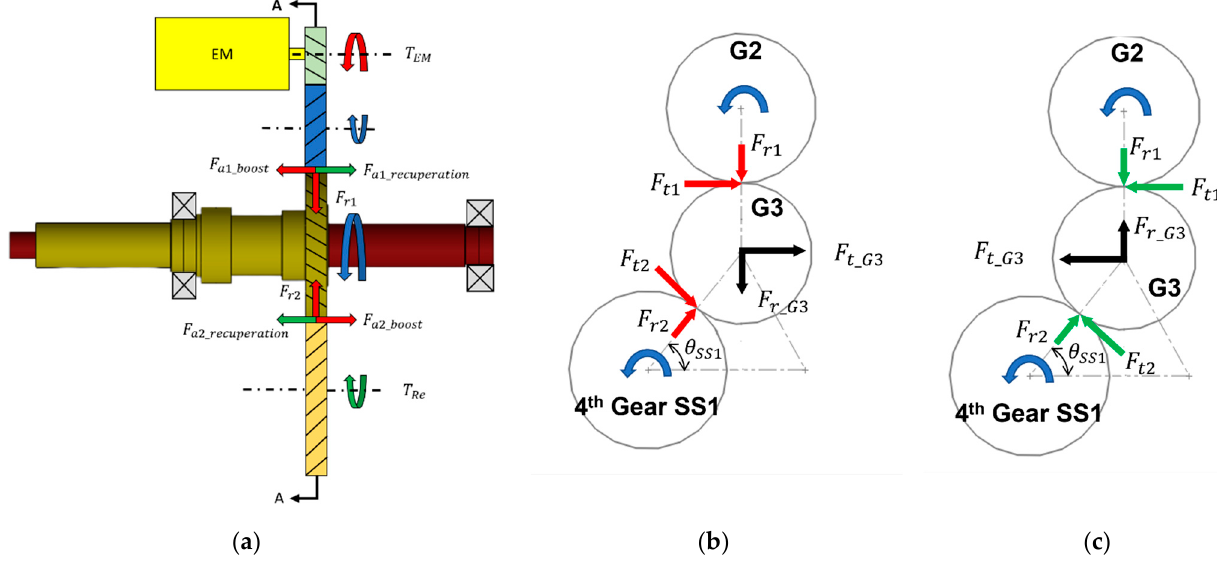
Figure 4. Fourth gear: ( a ) front view; ( b ) left hand side view in boost mode; ( c ) left hand side view in regeneration mode.